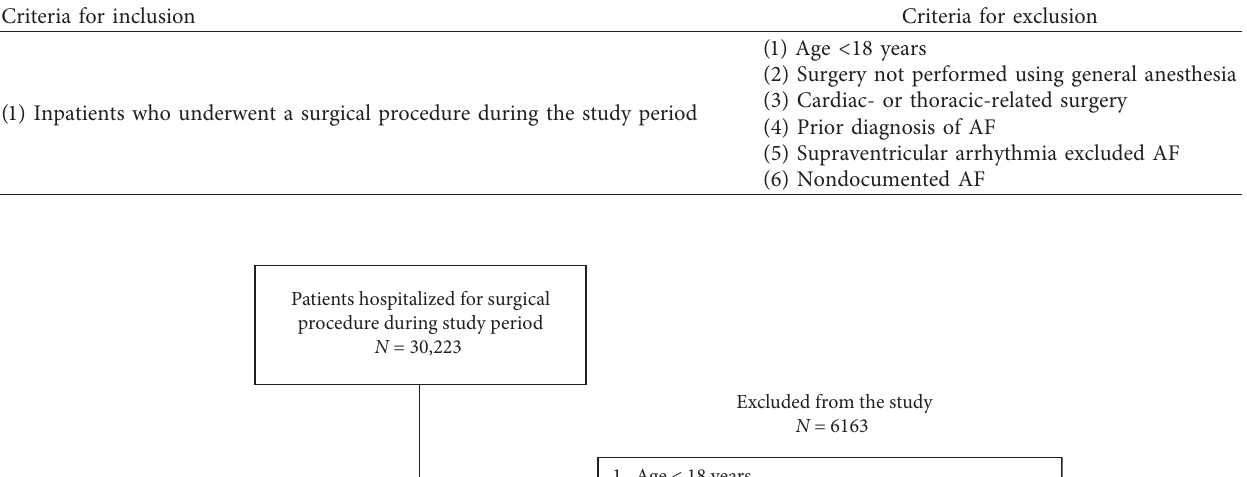
Table 1: Inclusion and exclusion